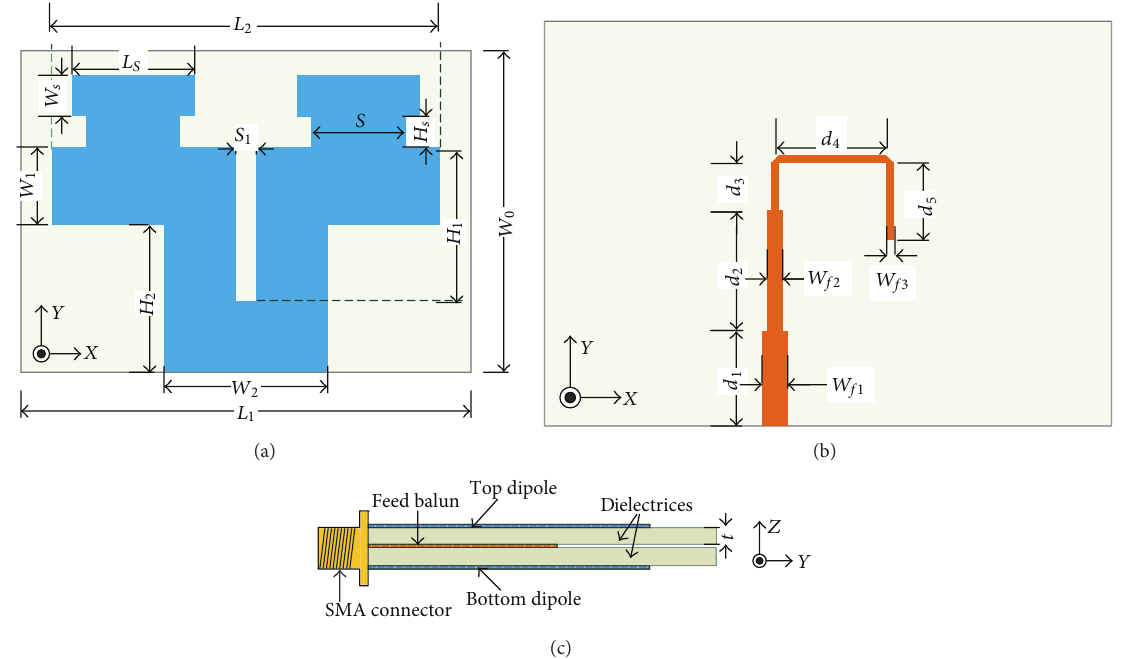
Figure 1: Configuration of the proposed double-sided antenna. (a) Top and bottom layers. (b) Interlayer. (c) Side